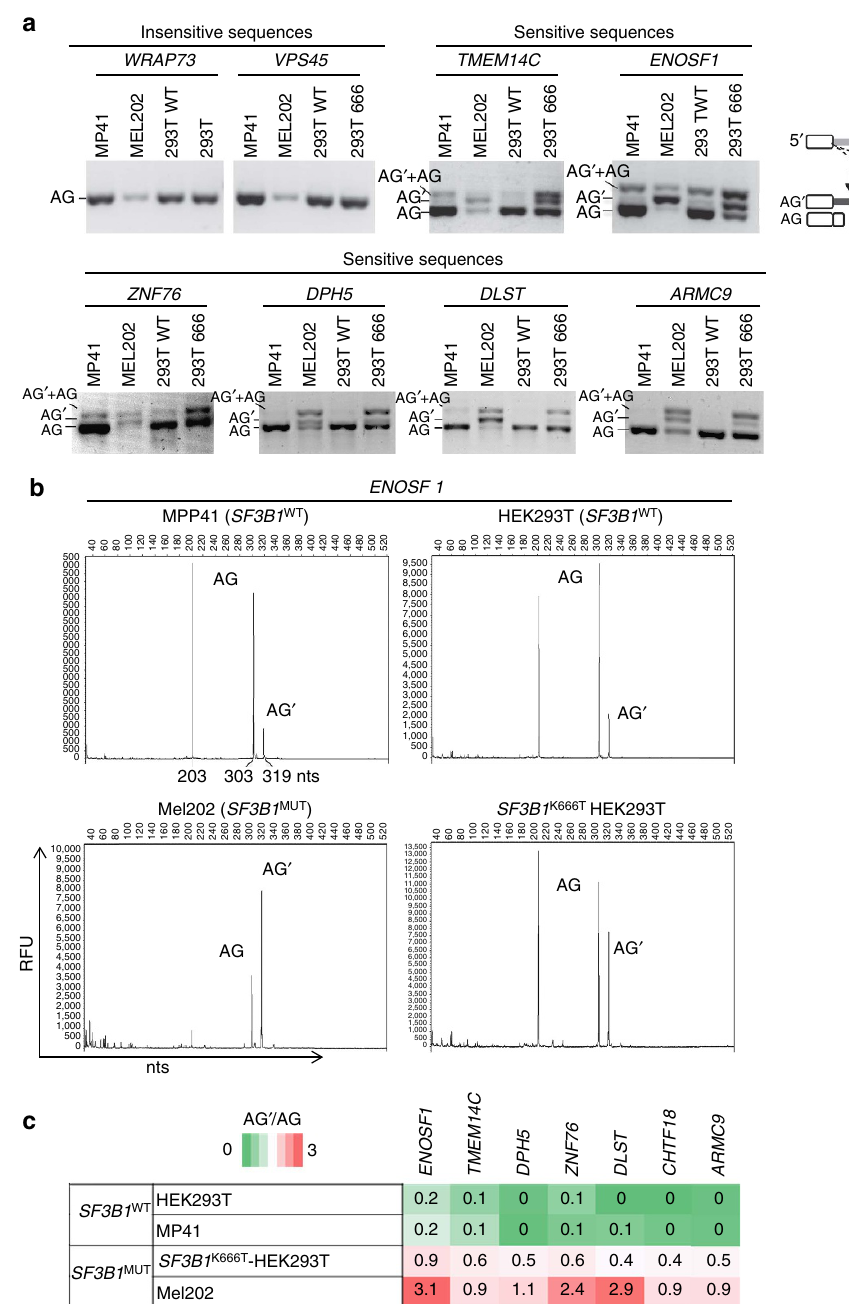
Figure 2 | In cellulo validation of differential splice junctions. ( a ) Minigene splice assay of two SF3B1 MUT -insensitive 3 0 ss ( WRAP73 and VPS45 ) and 6 SF3B1 MUT -sensitive 3 0 ss ( TMEM14C, ENOSF1, ZNF76, DPH5, DLST, ARMC9 ). Gel electrophoresis shows the different splicing processes for minigene ExonTrap constructions in SF3B1 WT cell lines (MP41 and HEK293T) and SF3B1 MUT cell lines (Mel202 and K666T- SF3B1 HEK293T). The lower band corresponds to the variant generated by the usage of the canonical 3 0 ss (AG). The intermediate band corresponds to a splice generated by the usage of the alternative 3 0 ss (AG’). The upper band is the heteroduplex formation from two bands (AG and AG’). ( b ) Analysis of alternative AG’ and canonical AG usage of the ExonTrap construct ( ENOSF1 ) in cell lines by capillary electrophoresis of RT–PCR products. Representative GeneMarker electrophoregrams for fragment analysis of ENOSF1 minigene cDNA expression are shown. The x axis represents molecular size (in nucleotides (nts)) of PCR products, and the y axis indicates relative fluorescent units (RFUs). The peak of 203nts refers to the internal splicing of the pET01 ExonTrap vector using its 3 0 ss and 5 0 ss. The peak of 303nts corresponds to the usage of the canonical AG, whereas the peak of 319nts corresponds to the usage of alternative AG’ WT. ( c ) Heat-map analysis using the AG’/AG ratio of the top differential splice junctions in cell lines as determined by capillary electrophoresis of RT–PCR products. corresponding canonical AG. AG-G is part of the recognition step of 3’ss recognition 16–18 . To test this hypothesis, MP41 and motif of U2AF1 (ref. 15). The low frequency of G nucleotide HEK293T cells were transiently transfected with si U2AF1 or immediately following alternative AG 0 sites suggests lesser si U2AF2 . Efficient knockdown was confirmed by immuno- dependence to U2AF1 compared with the canonical AG at the blotting. As shown in Fig. 4c, both U2AF1 and U2AF2 NATURE COMMUNICATIONS|7:10615|DOI: